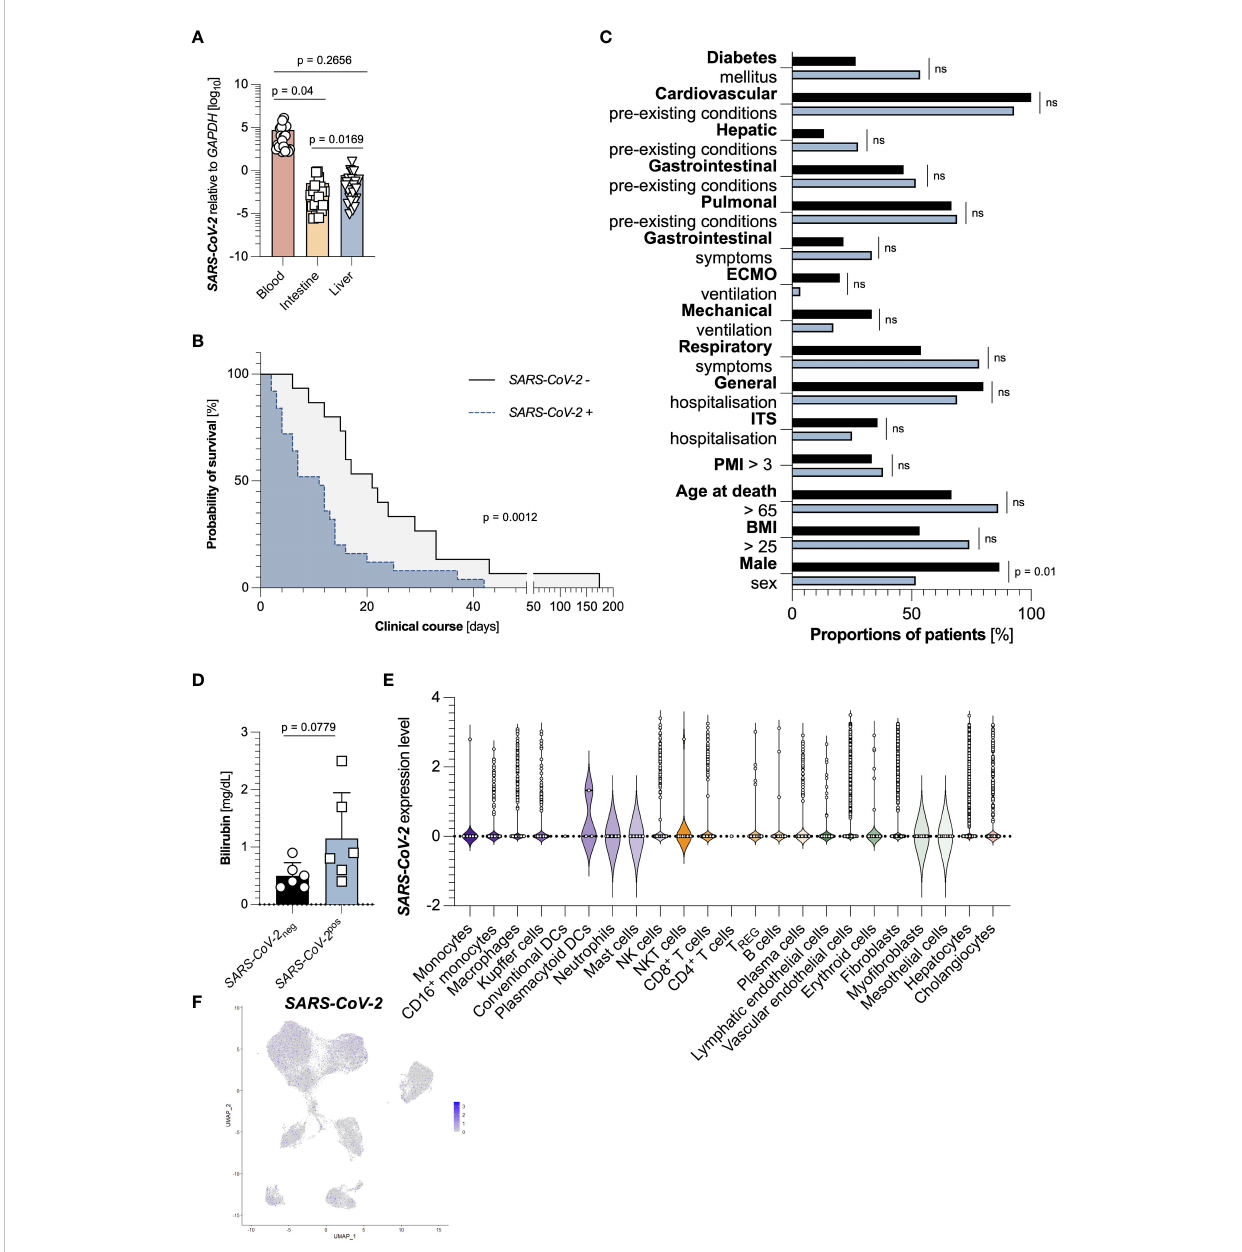
FIGURE 4 Intrahepatic SARS-CoV-2 detection is an independent factor for decreased survival time. (A) Relative expression of SARS-CoV-2 to GAPDH in the blood (left, red, n=44), the intestine (middle, yellow, n=45), and the liver (right, blue, n=44), as measured by RT-PCR. (B) Kaplan Meier analysis of survival length in patient cohorts divided according to an undetectable hepatic expression of SARS-CoV-2 (n=15, black), and a detectable hepatic expression of SARS-CoV-2 (n=29, blue) in the liver. (C) Cohort characteristics of patients with undetectable hepatic expression of SARS-CoV-2 (n=15, black), and detectable hepatic expression of SARS-CoV-2 (n=29, blue) in the liver. (D) First available levels of bilirubin (mg/dL, n=12) upon SARS-CoV-2 diagnosis, determined by screening of patient´s laboratory fi ndings, divided according to undetectable (black, left, n=6) and detectable (blue, right, n=6) hepatic SARS-CoV-2 expression. Statistics by Mann-Whitney test. (E) SARS-CoV-2 expression divided by cell cluster from the livers of 15 SARS-CoV-2 infected patients. (F) SARS-CoV-2 expression in cell clusters from the livers of 15 SARS-CoV-2 infected patients identi fi ed using single-cell sequencing. Horizontal lines represent means ± SEM; each symbol indicates one sample from one patient. ns, not signi fi